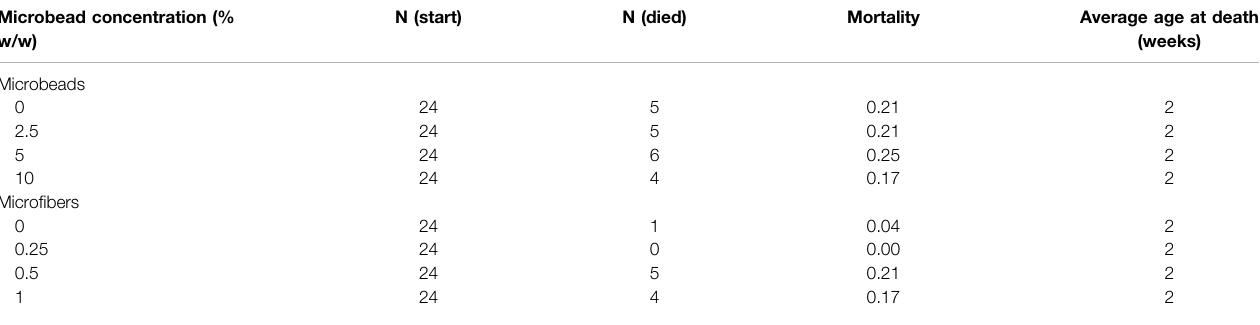
TABLE 1| Mortalityof Gryllodessigillatus duringMPfeedingexperiments. Cricketsthatdied orwerelost duringmeasurementwereexcludedfrom theexperiment. N(Start): Number ofcricketsatthebeginningoftheexperiment. N(Died):Numberofcricketsthatdied duringtheexperiment. Mortality: Proportionofcricketsthatdied duringthe